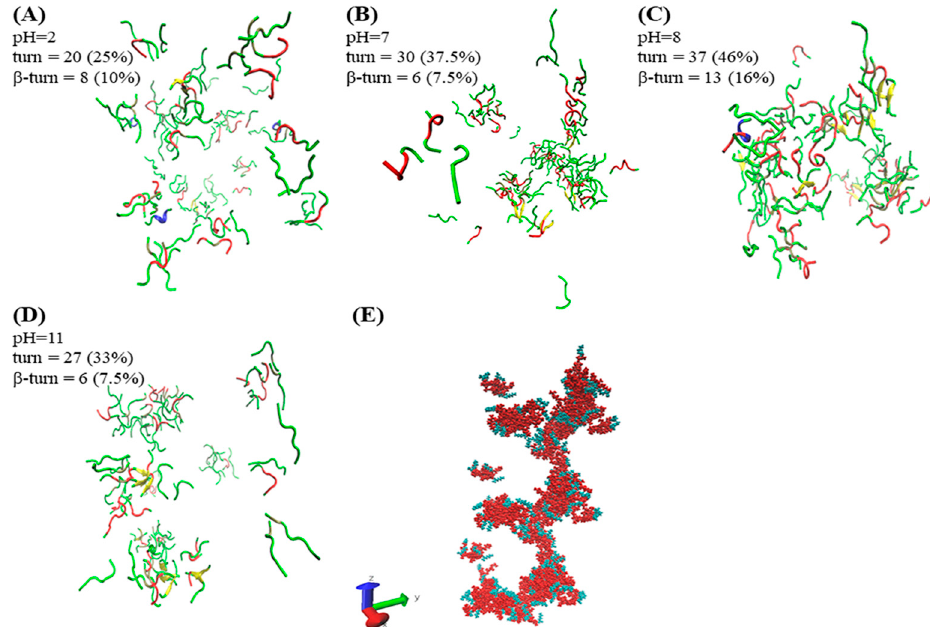
Figure 4. Final snapshots (at time = 20 ns) of assemblies for A 6 K were generated with visual molecular dynamics (VMD) at different pH [28]. The water and ions are not shown for better clarity of the figure. ( A–D ) shows the simulation results using the secondary structure in VMD (the secondary structure algorithm uses STRIDE). The secondary structures of turn, helix, coil, and sheet are represented by red, blue, green, and yellow, respectively. ( E ) shows the periodic display of the aggregates in the z- axis at pH